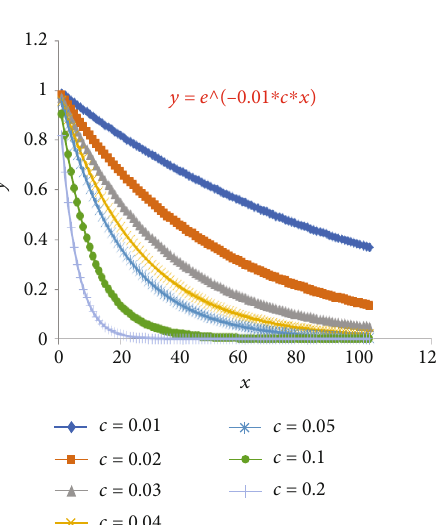
Figure 1: Stress-sensitive index.